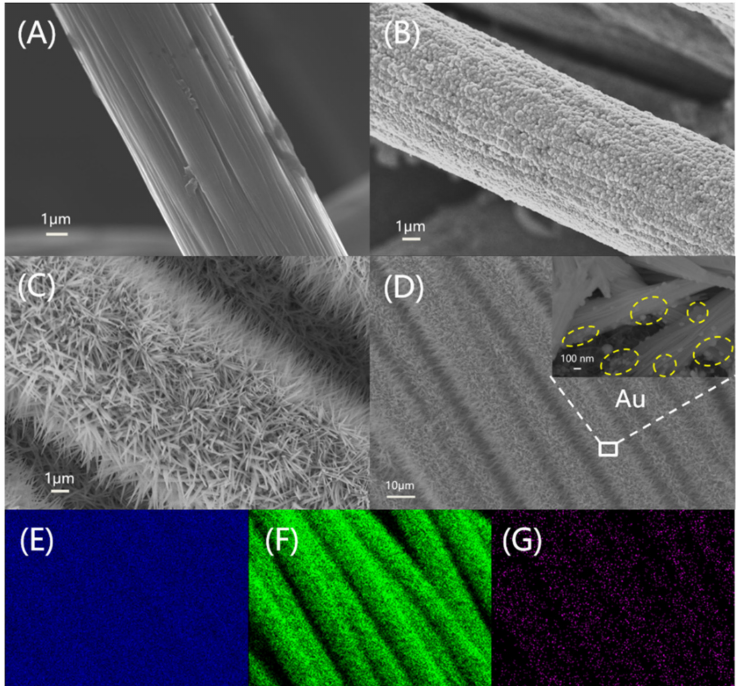
Figure 2. High-magnification SEM images of ( A ) CFC, ( B ) Cu / CFC and ( C ) Cu(OH) 2 / CFC, ( D ) Low- magnification SEM image of Au@Cu(OH) 2 / CFC (Inset is the partial enlarged view), EDX elemental mapping images of ( E ) Cu, ( F ) O and ( G ) Au corresponding to ( D